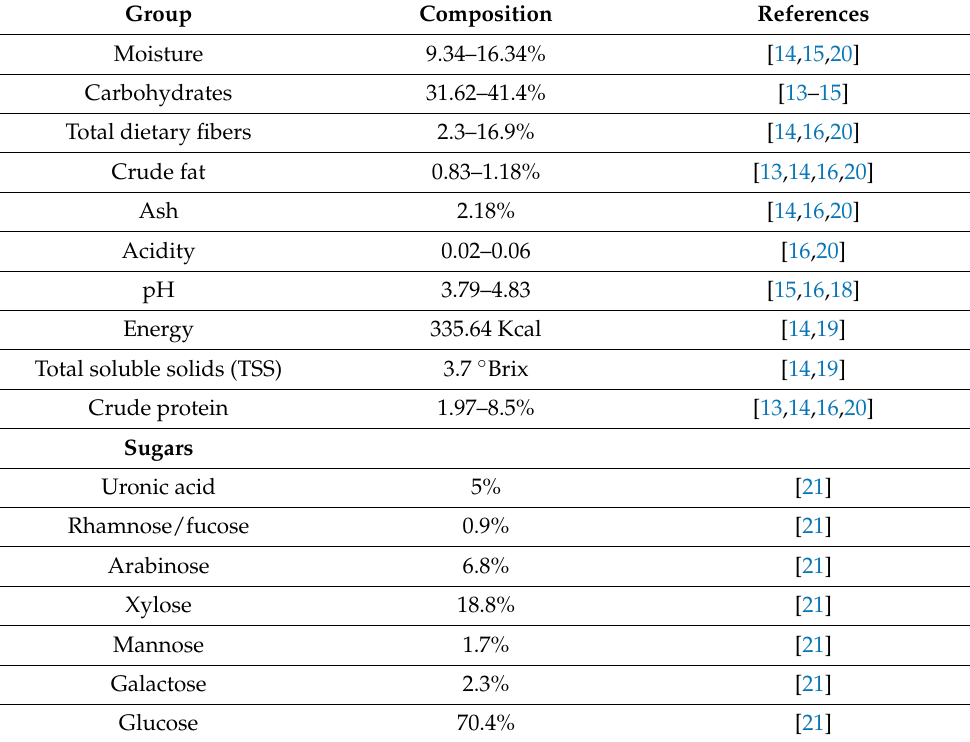
Table 1. Nutritional profile of JSs.